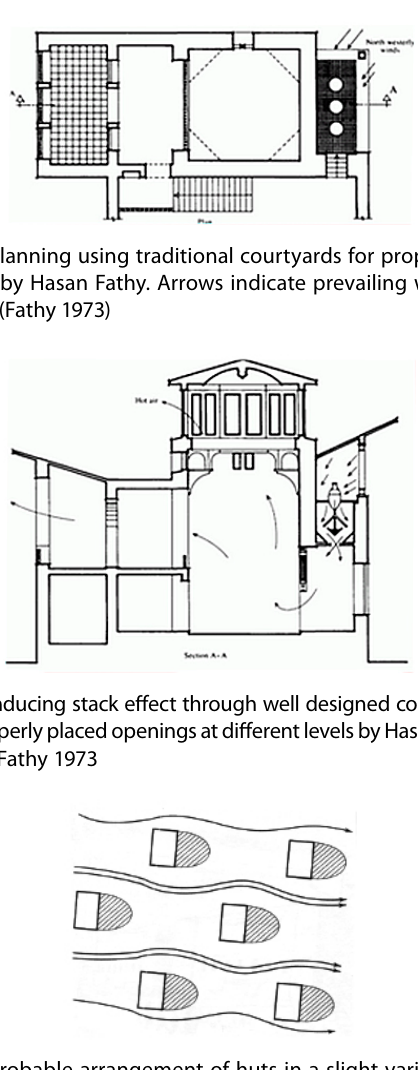
fig. 7. Probable arrangement of huts in a slight variation of fig. 8. location of ranchi in Composite climate region Source: SP 7:2005, national Building Code of India